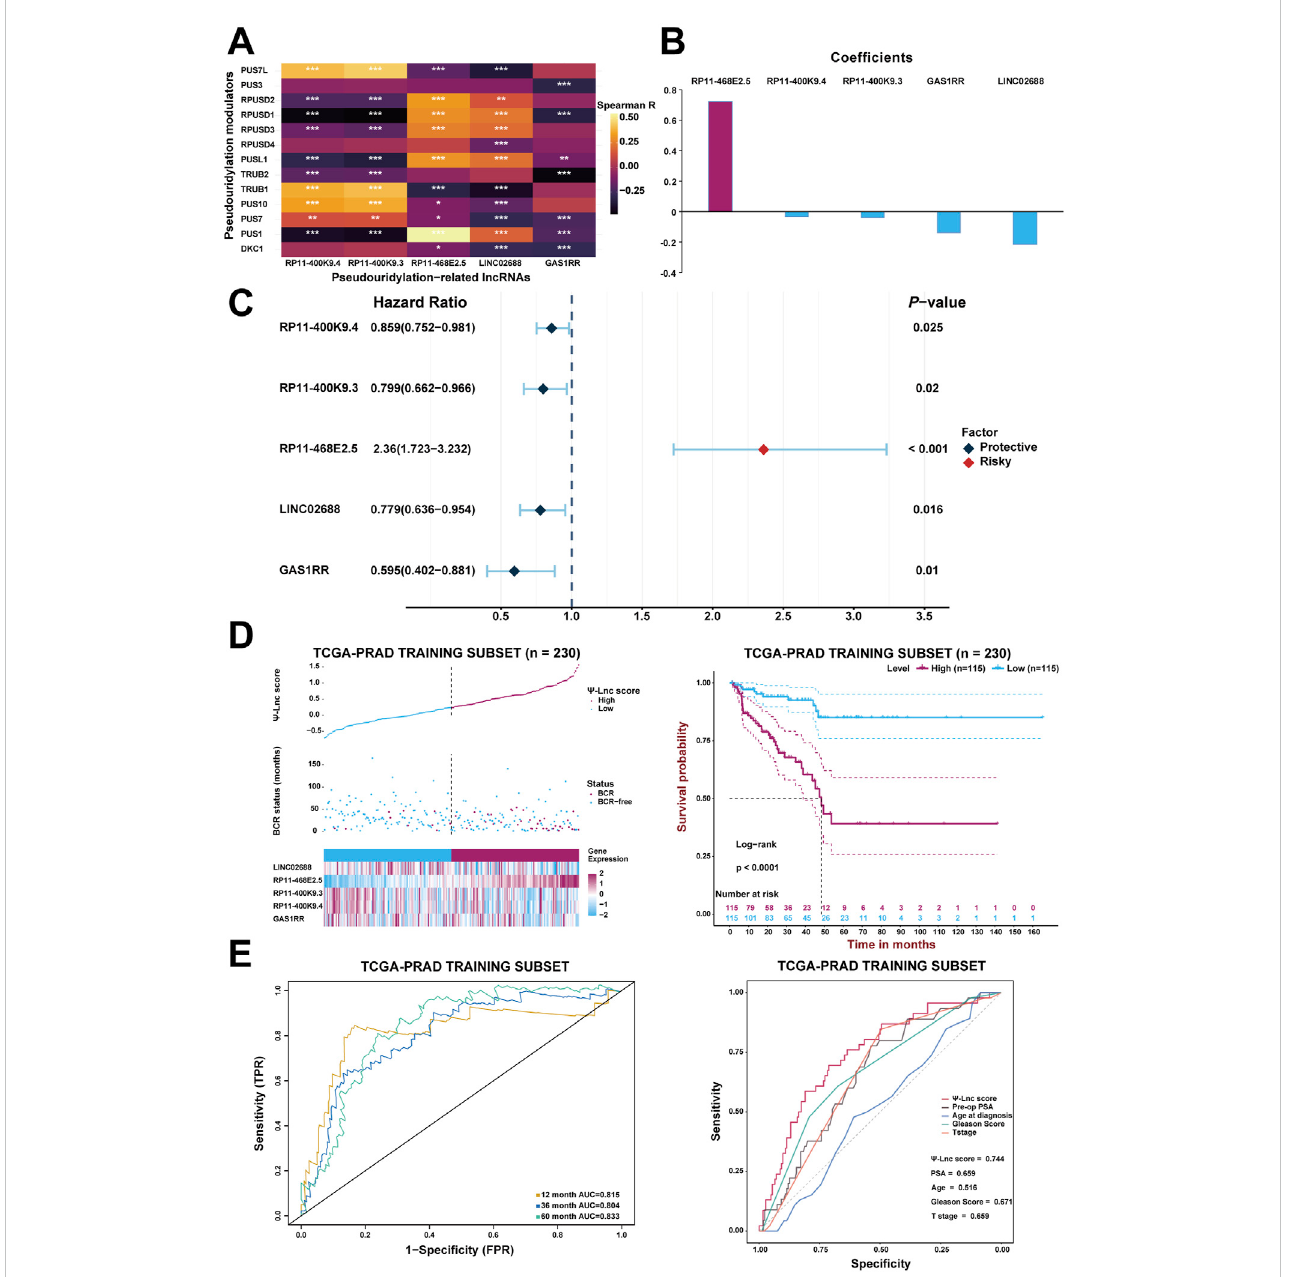
FIGURE 3 Construction of the prognostic model with Ψ -related lncRNAs. (A) The heatmap demonstrates the correlation between the 13 Ψ genes and the fi ve lncRNAs included in the model. * p < .05; ** p < .01; *** p < .001. (B) The coef fi cients of each selected lncRNA in the Ψ -lnc scoring formula. (C) The forest plot shows the univariate Cox regression results of the fi ve lncRNAs. (D) The fi rst diagram depicts PCa patients ’ pro fi les on three aspects, Ψ -lnc score, BCR status, and the fi ve genes ’ expression levels, in the TCGA training subset. The second one shows the Kaplan-Meier BCR survival analysis between two Ψ -lnc score subgroups in the training subset. (E) The ROC curves show the accuracy of the Ψ -lnc score in predicting BCR-free survival, and the Ψ -lnc score outperforms other clinical